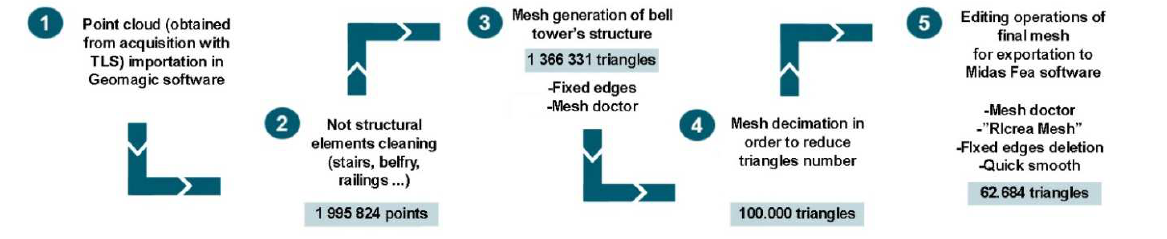
Figure 8 - Operations in Geomagic© software